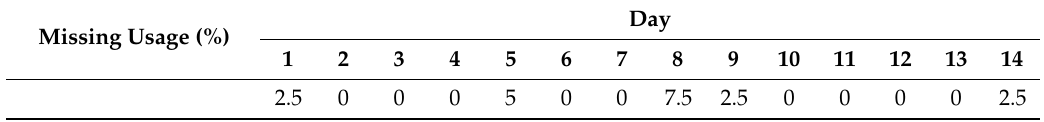
Table 3. Usage by the